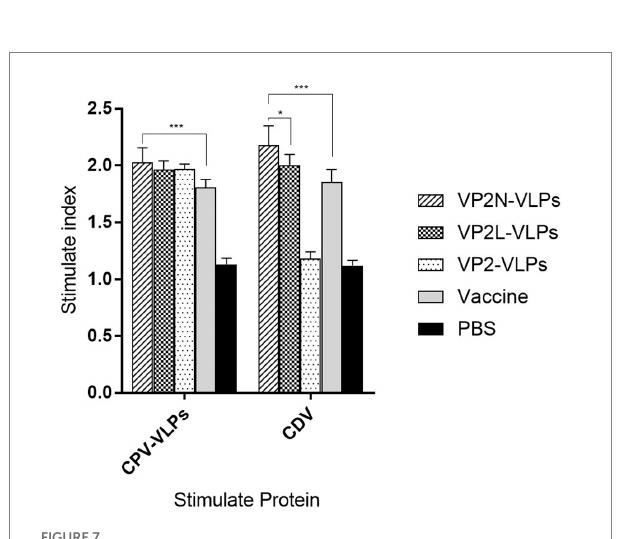
FIGURE 7 Lymphoid proliferation assay of mice with the stimulation of CPV or CDV at 56 dpi after immunization with CPV VP2/VP2N/VP2L in mice. Each group of 6-week-old Balb/c mice ( n = 10) were immunized subcutaneously with 50 μ g of VP2, VP2L, VP2N recombinant protein, 100 μ l CPV/CDV live-attenuated vaccine and 100 μ l PBS at 0, 14, 28 dpi. Data were analyzed using GraphPad 5.00. Asterisks indicate significant differences among the groups, as calculated by one-way ANOVA (* p < 0.05, *** p <